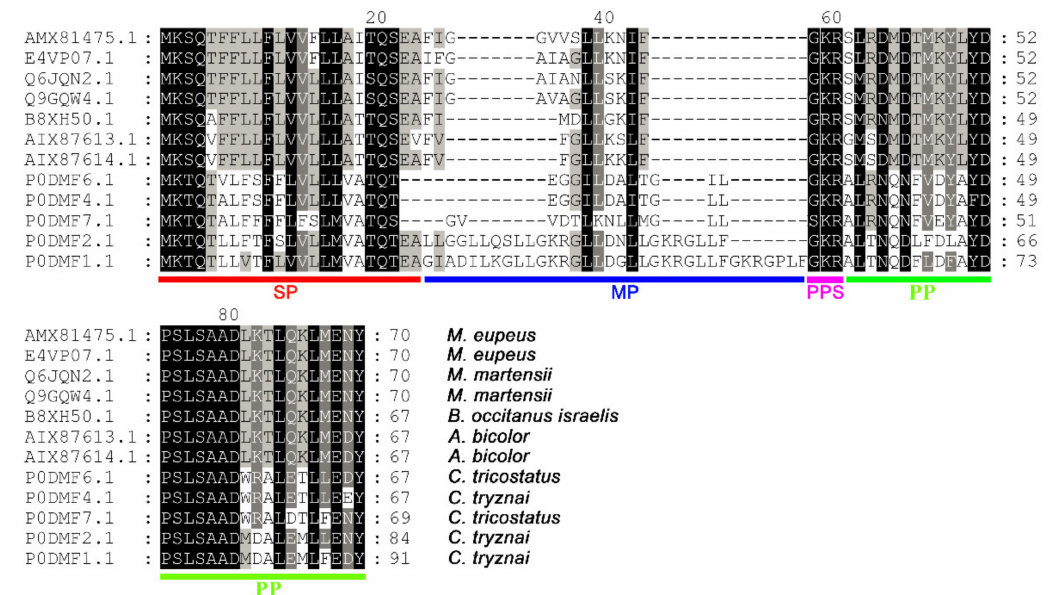
Figure 2. Multiple sequence alignments of the scorpion venom peptide Ctri9594 with its homologs. Sequence alignments of Ctri9594 with similar scorpion venom peptides were carried out by GeneDoc. The residues in black are highly conserved sites, the residues represented by dashes are less conserved sites and the residues without background color are highly various sites. AMX81475.1 and E4VP07.1 are from Mesobuthus eupeus . Q6JQN2.1 and Q9GQW4.1 are from Mesobuthus martensii . B8XH50.1 is from Buthus occitanus israelis . AIX87613.1 and AIX87614.1 are from Androctonus bicolor . P0DMF6.1 and P0DMF7.1 (corresponding to Ctri9594) are from Chaerilus tricostatus . P0DMF1.1, P0DMF2.1 and P0DMF4.1 are from Chaerilus tryznai . SP, signal peptide. MP, mature peptide. PPS, posttranslational processing signal. PP,